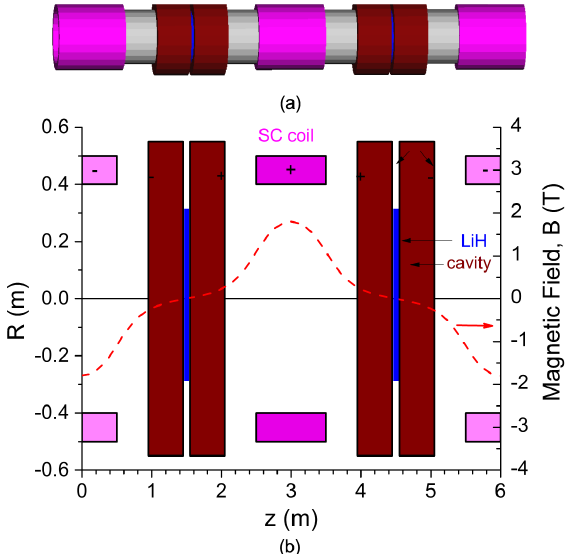
FIG. 4. Schematic representation of the ICL lattice: (a) Con- figuration in 3D; (b) side view. Note that two cells are shown. The magenta cylinders are solenoids, the red cylinders are the active volume of the rf cavities, and the blue blocks are LiH absorbers. The dashed red line shows the magnetic field distribution along the axis. The current density of each coil is 19 . 3 A = mm 2